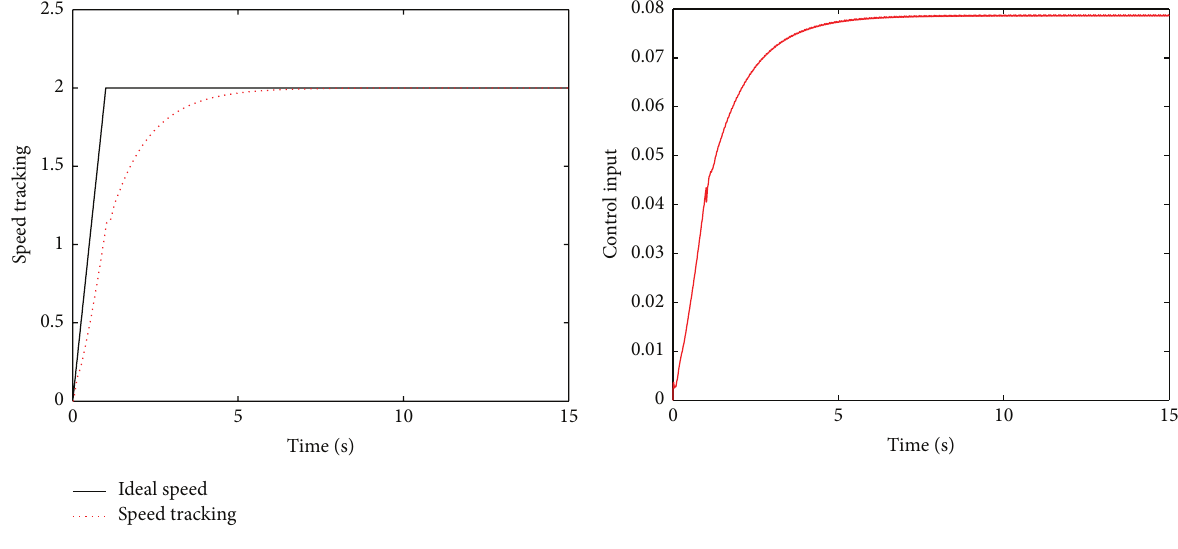
Figure 11: Simulation curve based on PID control law at constant speed.